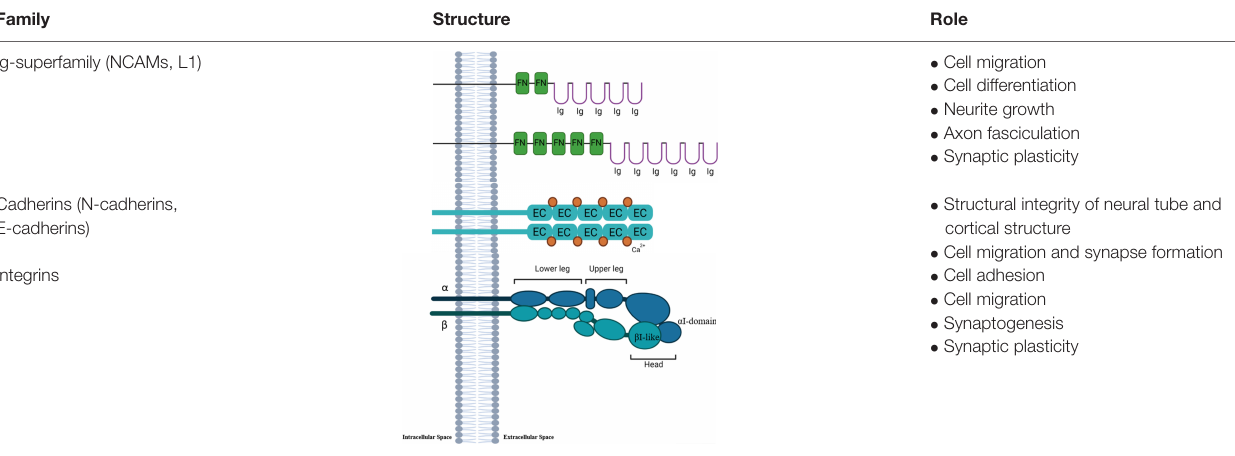
TABLE 1 | Structure and role of CAMs during central nervous system development. Family